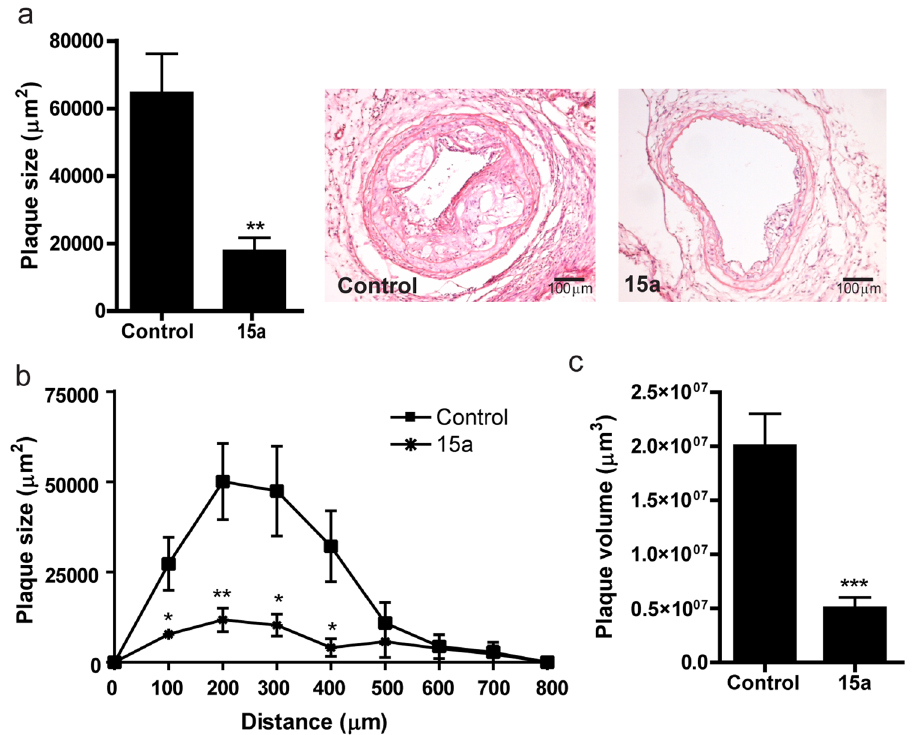
Figure 5. Inhibition of lesion development in the carotid artery by 15a. ( a ) The CCR2 antagonist 15a significantly reduced atherosclerotic plaque size in the carotid artery at the site of maximal stenosis. ( b ) Similarly, plaque volume, given as plaque size at increasing distance from the collar and ( c ) as total volume in µ m 3 was significantly reduced by 15a. Micrographs show representative images of the individual groups (100X magnification). * P < 0.05, ** P < 0.01, *** P < 0.001. Graphs shown are representative from one experiment with n = 10 controls versus n = 9 15a-treated